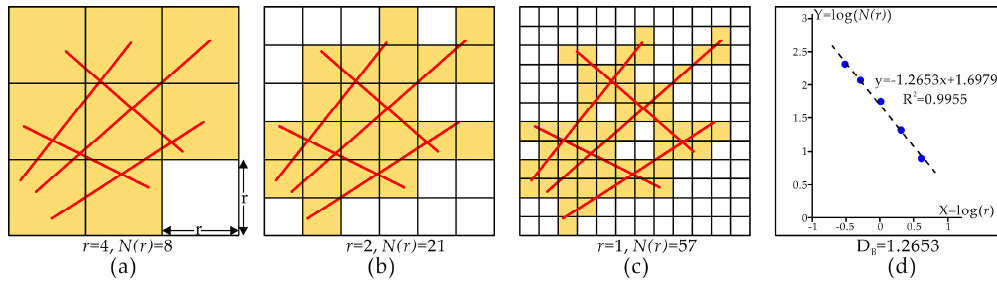
Figure 3. Schematic diagram of box-counting method for measuring a fractal linear pattern: ( a ) 8 boxes containing parts of target lines with box size r = 4; ( b ) 21 boxes counted with box size r = 2; ( c ) 57 boxes counted with box size r = 1; and ( d ) log–log plot revealing the power law relationship of counted box number N ( r ) and box size r , obtaining box-counting fractal dimension D B = 1.2653.